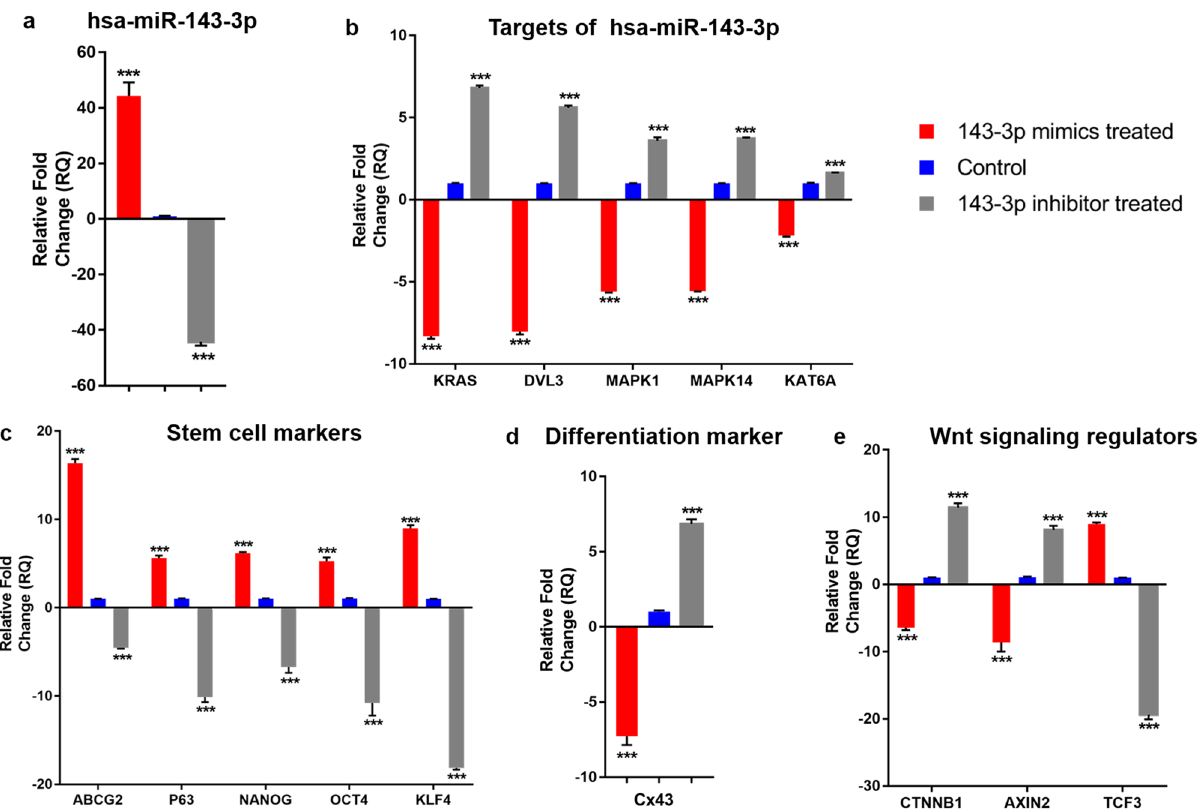
Figure 1. mRNA expression profile of hsa-miR-143-3p transfected cells. Expression profile of ( a ) hsa-miR- 143-3p, ( b ) its predicted targets, ( c ) stem cell markers, ( d ) differentiation marker and ( e ) Wnt signaling regulators upon transfection with hsa-miR-143-3p mimic and inhibitor. Relative mRNA/miRNA expression in mimic transfected and inhibitor transfected cells were quantified in comparison to control by qPCR using SYBR Green chemistry. Each sample (n = 3) was run in triplicate. The data were expressed as mean ± SD and relative fold change of expression (RQ) was calculated by 2 −∆∆CT method after normalization with GAPDH (reference gene)/ RNU6B (reference miRNA). *** P <